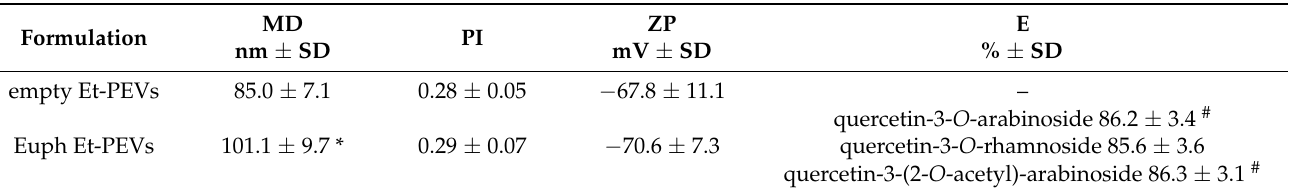
Table 3. Characteristics of empty and E. characias (Euph) Et-PEVs: mean diameter (MD), polydis- persity index (PI), zeta potential (ZP), and entrapment efficiency (E). Each value represents the mean ± SD ( n >